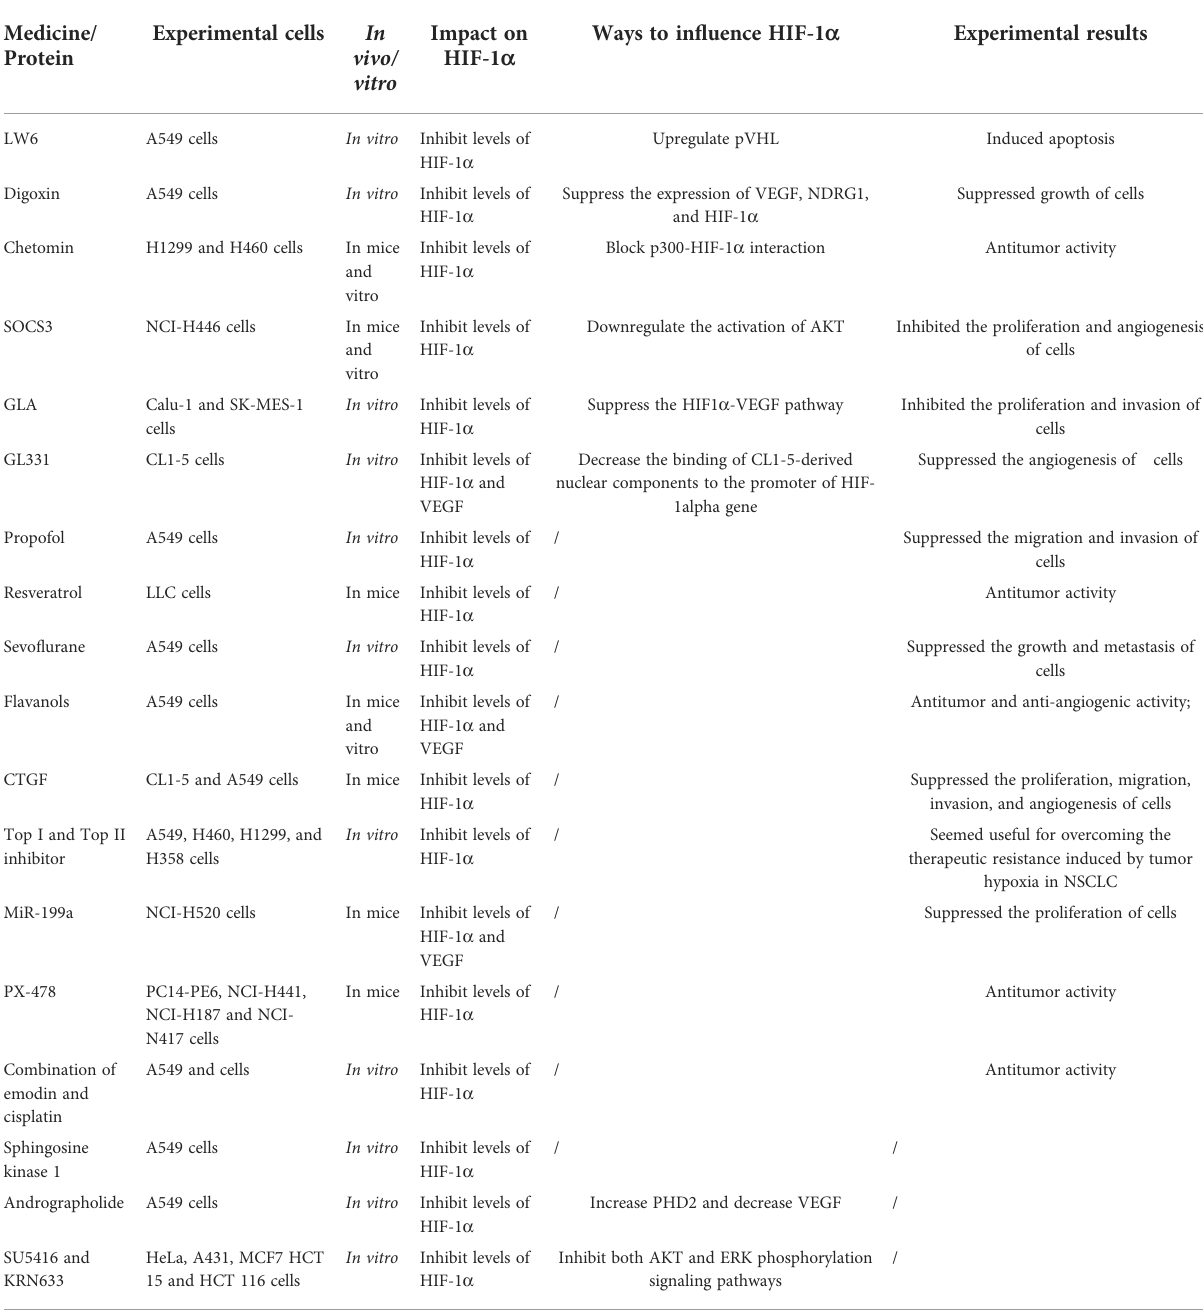
TABLE 3 Substances that can target HIF-1 a in lung